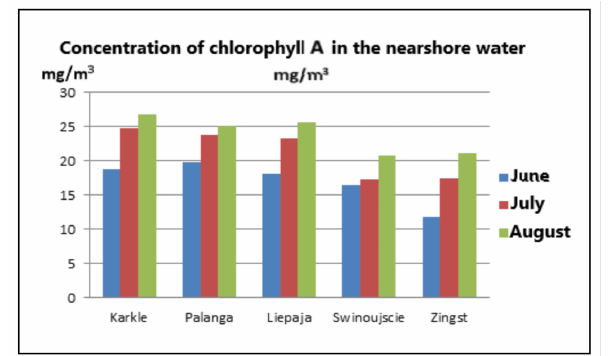
Figure 5. Average chlorophyll A concentration in the nearshore water in the summer months of 2015 to 2019 (our